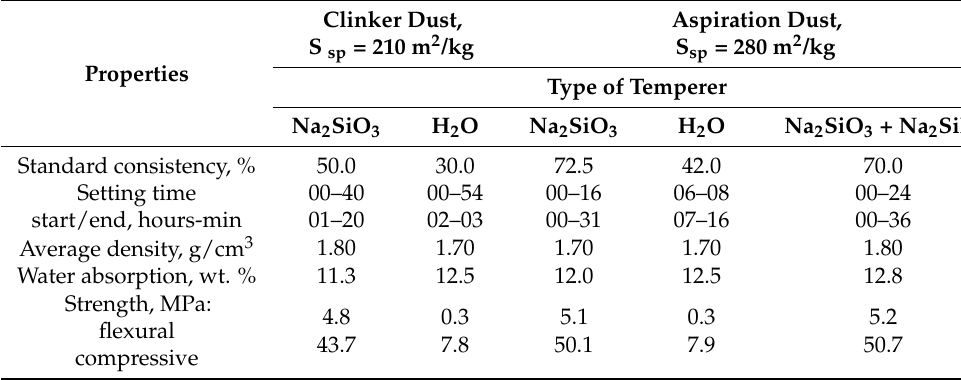
Table 6. Fresh, physical, and mechanical properties of the